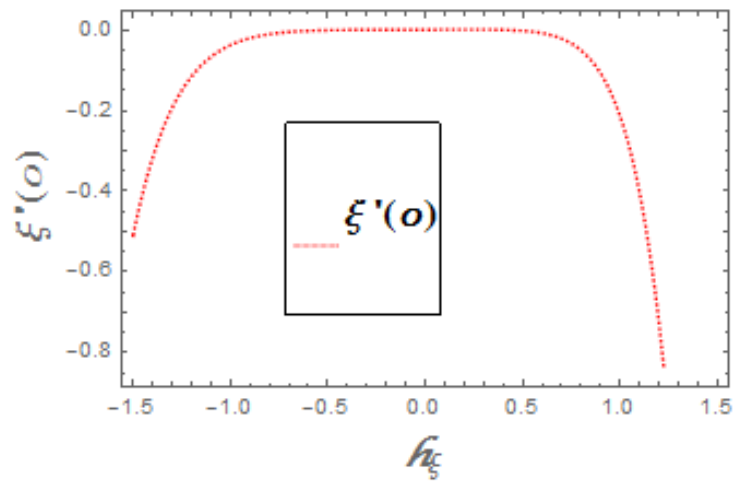
Figure 22. The h-curve graph for ξ (cid:48) ( 0 ) .